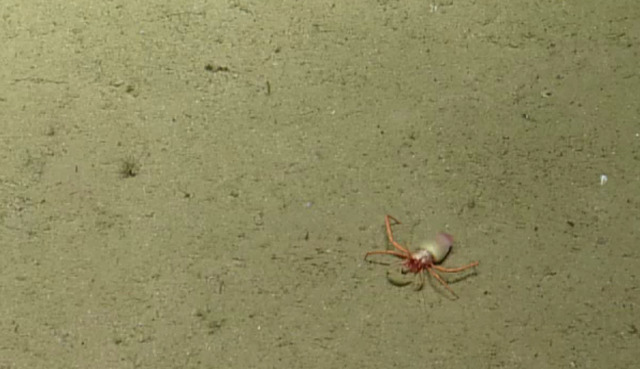

Tylaspis
anomala